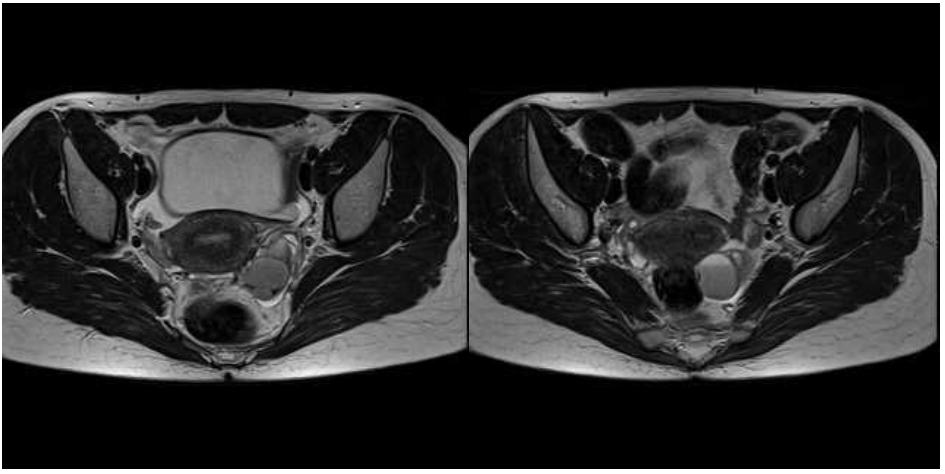
Figure 3. T2 TSE weighed sequences. Complex images in the left ovary, fluid/fluid level, hypointense images in the declive position, axially.